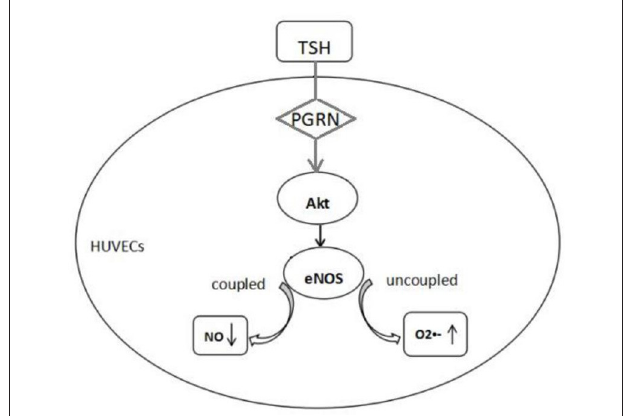
FIGURE 8 | Proposed mechanism of endothelial dysfunction induced by TSH. TSH up-regulated eNOS expression in HUVECs by PGRN through Akt pathway. Reduction in NO production and increase in superoxide anion indicated uncoupled eNOS.